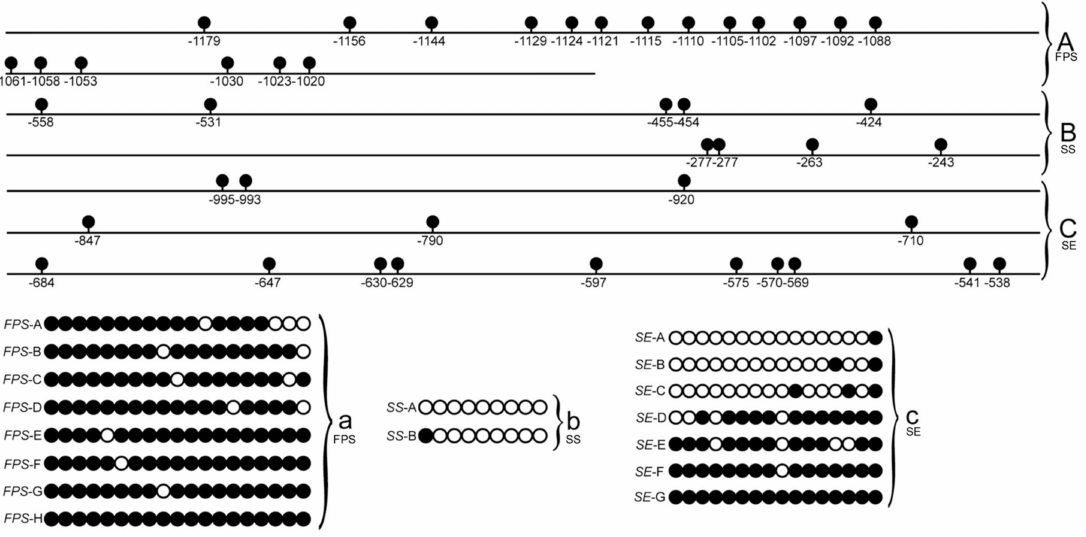
Figure 1. Distribution diagram and map of the types of methylation sites of the promoters of E . senticosus FPS , SS , and SE genes. Black circles correspond to methylated CpG inislands. Filled (black) circles correspond to methylated C molecules, unfilled (white) circles correspond to unmethylated C molecules. ( A ): Schematic diagram of DNA methylation site of FPS gene; ( B ): Schematic diagram of DNA methylation site of SS gene; ( C ): Schematic diagram of DNA methylation site of SE gene; ( a ): Schematic diagram of DNA methylation type of FPS gene; ( b ): SS Schematic diagram of the type of DNA methylation; ( c ): Schematic diagram of the methylation type of SE gene